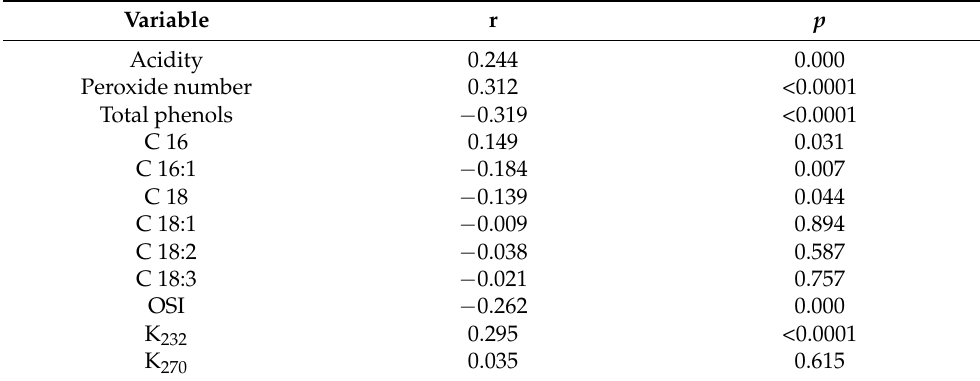
Table 4. Pearson correlation between oil chemical parameters and olive storage duration.